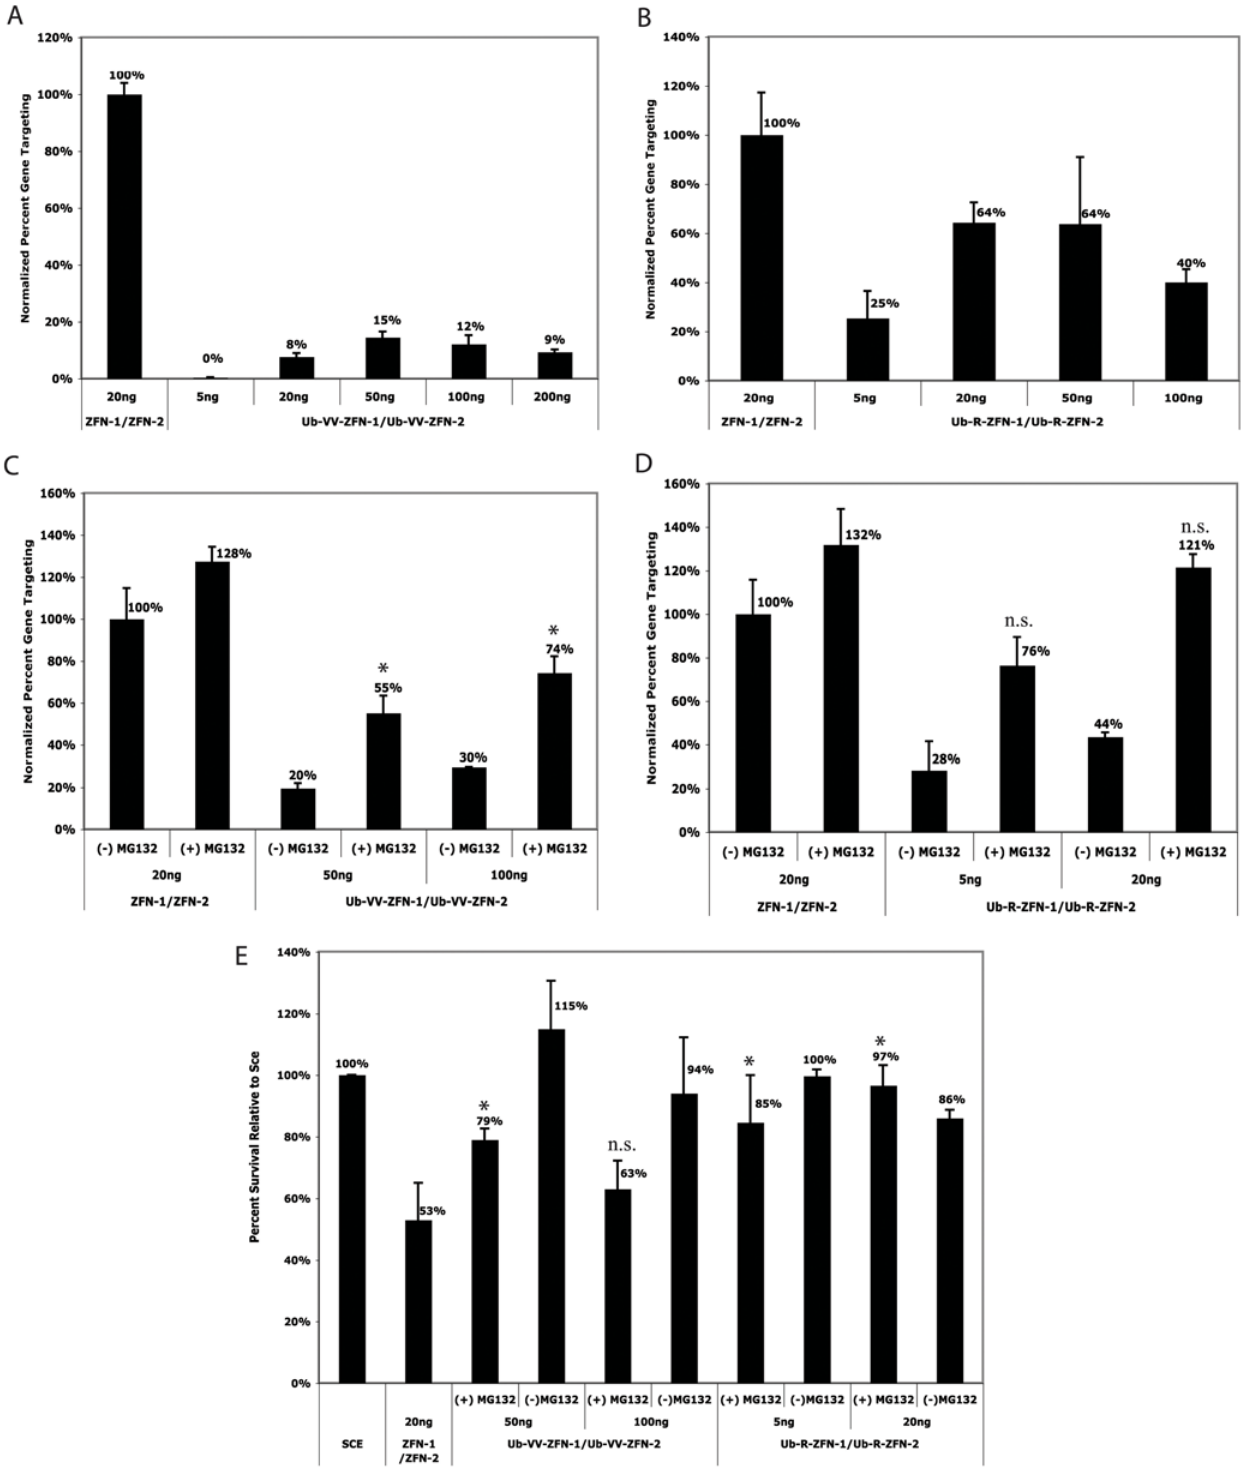
Figure 2. Analysis of Ub-X-ZFNs. Unless otherwise indicated, rates of gene targeting at day 3 were normalized to the rate of gene targeting achieved using 20 ng of the unmodified ZFNs without drug treatment as this was previously determined to be the conditions used to obtain optimal gene targeting with the unmodified ZFNs. The absolute rate of gene targeting using ZFN-1/ZFN-2 at 20 ng in HEK 293 cells was about 20,000 GFP positive cells per million cells transfected (about 2%). (A) Titration of transfected DNA of Ub-VV-ZFNs in the gene targeting assay with increasing amounts of DNA. (B) Titration of transfected DNA of Ub-R-ZFNs in the gene targeting assay with increasing amounts of DNA. (C and D) Gene targeting in the absence and presence of 10 uM MG132 for given ZFN pairs at stated DNA concentrations. (E) Toxicity assay for all iterations of Ub-modified and unmodified ZFNs tested in the gene targeting assay relative to Sce. A value of , 100% indicates decreased cell survival as compared with Sce, and demonstrates a toxic effect. Statistical analysis was performed using the Student’s T-test comparing ZFN-1/ZFN-2 at 20 ng with no drug treatment to Ub-modified ZFNs treated with MG132. ‘‘*’’ indicates a P-value of , .05 and ‘‘n.s.’’ indicates no statistical significance or a P-value of . .05. Error bars are the standard deviation for three samples. doi:10.1371/journal.pgen.1000376.g002 PLoS Genetics |